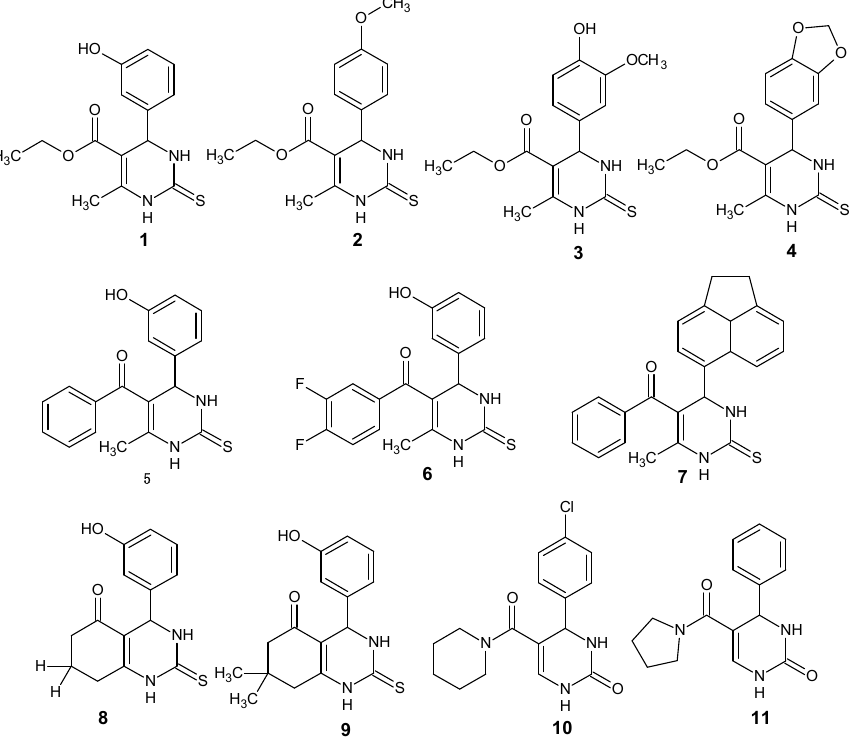
Figure 1. Dihydropyrimidine derivatives demonstrating anticancer activity.